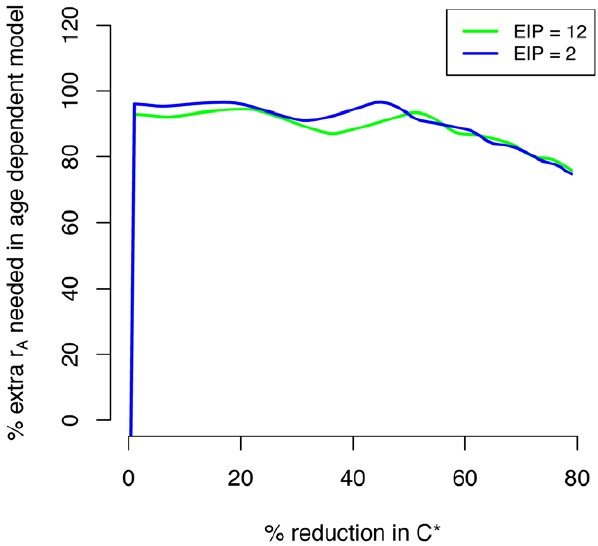
Figure 6. Constant hazard assumptions cause models to overestimate effectiveness of reduced mosquito survival in reducing transmission. The percent increase in the daily probability of death due to intervention ( r A ) required to reach a threshold percentage reduction in scaled vectorial capacity ( C* ) in an age dependent mortality model compared to a constant mortality model is plotted as a function of the threshold reduction desired. For most meaningful percentage reductions in C* , the age dependent model predicts that r A will need to be about twice as great compared to the constant model. The constant model overestimates control efficiency by nearly the same amount regardless of the extrinsic incubation period